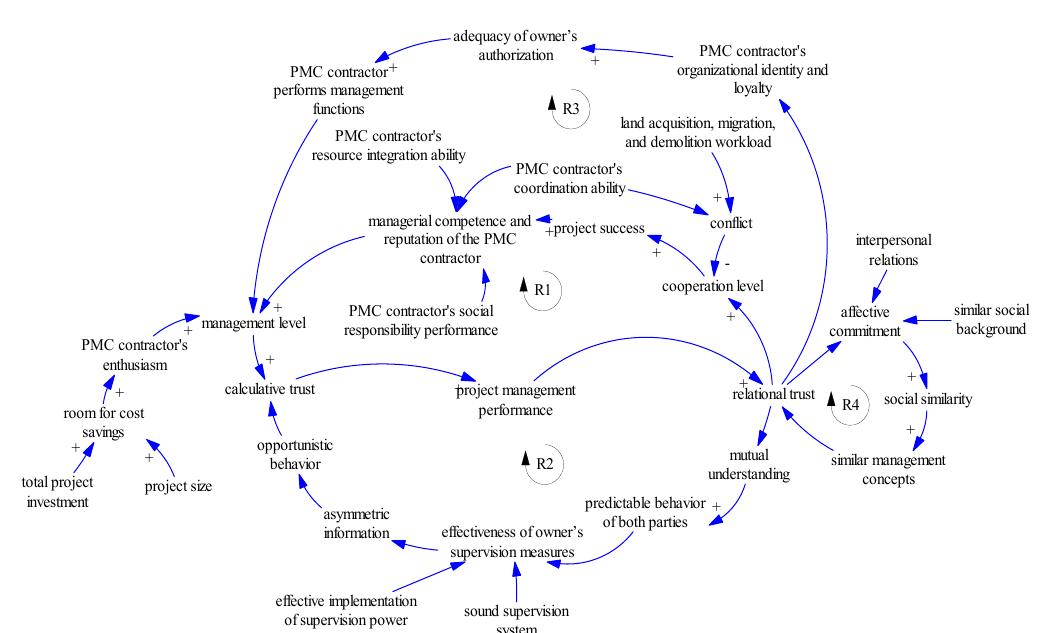
Figure 1. Cause loop diagram of trust generation between the owner and the PMC contractor.